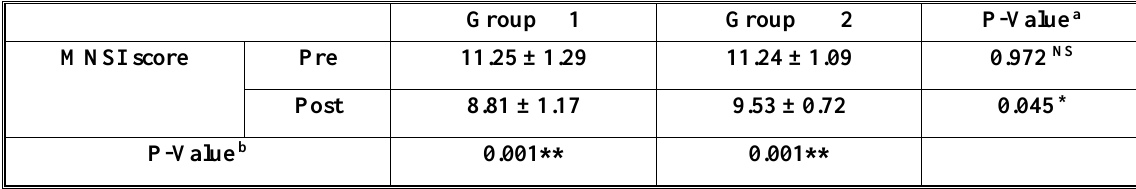
Table 2. Effect of treatment on MNSI in patients with diabetic